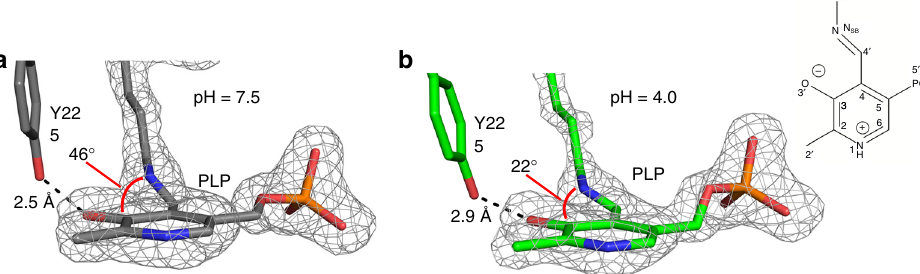
Fig. 6 X-ray structures of AAT at different pH. Internal aldimine at pH 7.5 a and pH 4.0 b . The gray mesh is the omit | F o | − | F c | difference electron density at